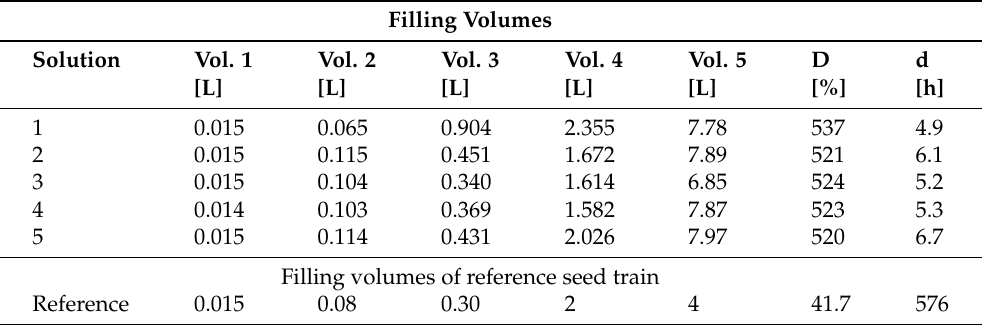
Table 3. Pareto optimal solutions concerning the choice of filling volumes in shake flask scales, for three scenarios for 5 flask scales. The following bioreactor filling volumes are 40 L, 320 L and 2210 L. The averaged filling volumes in L and the resulting deviation rate ( D ) in % and seed train duration ( d ) in h are listed for each Pareto optimal